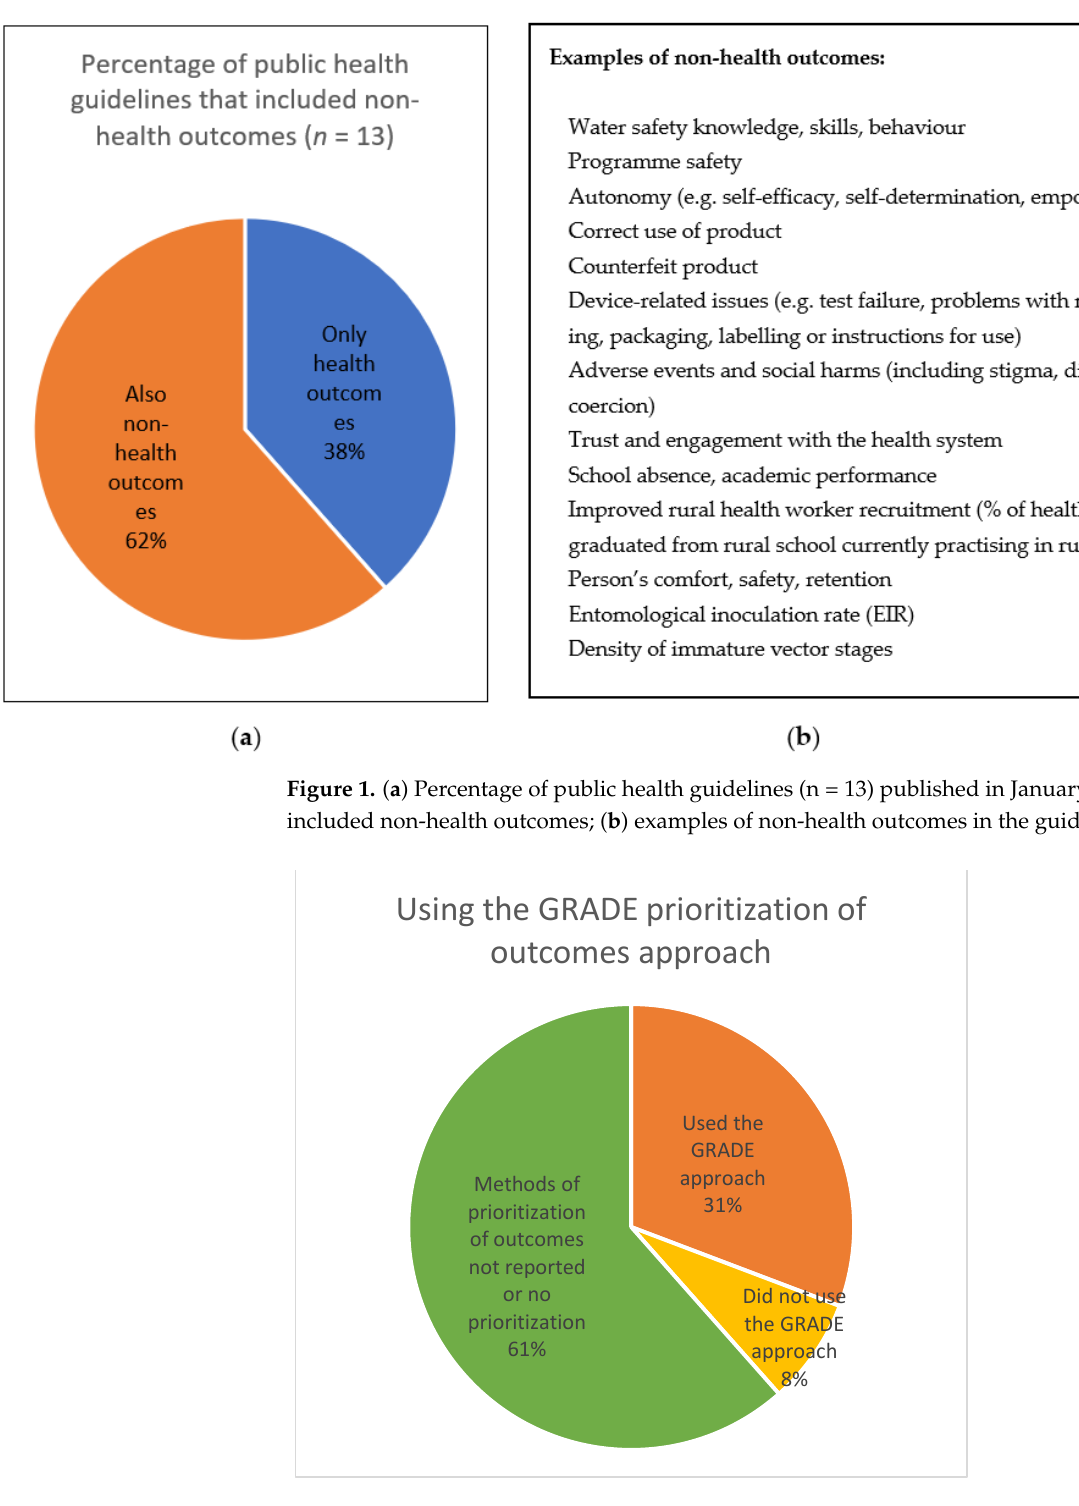
Figure 2. The use of the GRADE approach to prioritization of outcomes. (The GRADE approach defined as: ranking of outcomes 1–9, and dividing into critical, important, non-critical.). Table 3. Categories and codes for theme 2.